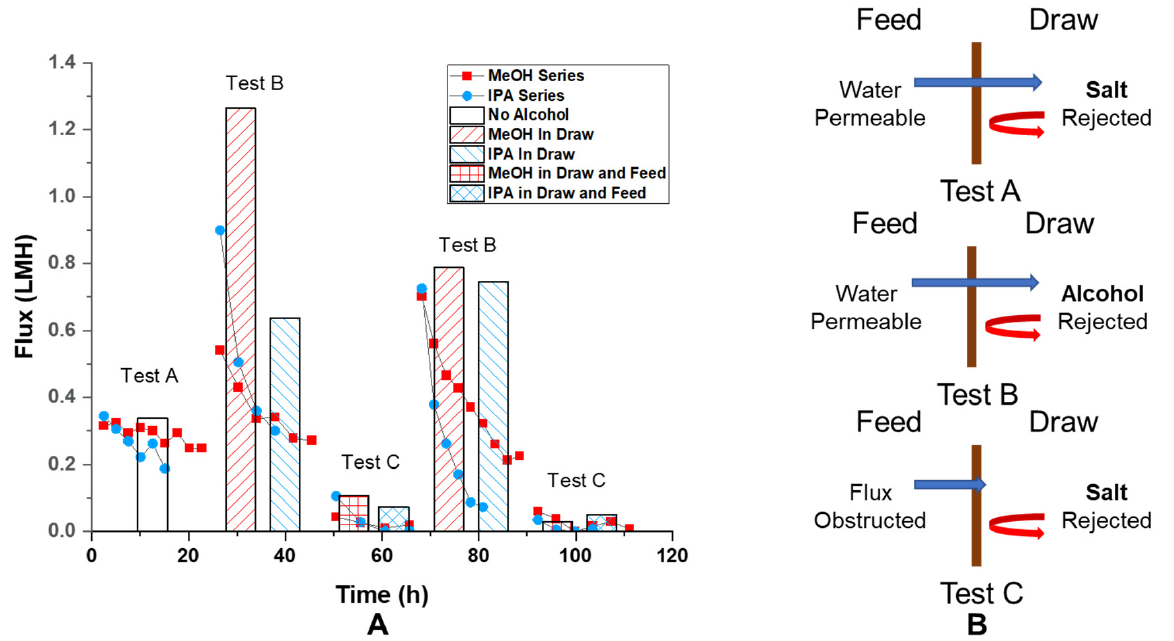
Figure 3. ( A ) Observed osmotic flux vs. time trend on the same GO membrane under different test conditions (scatter plot) and average extrapolated initial flux of different GO membranes under various test conditions (columns); ( B ) schemes of cross-membrane flux under different test conditions. Test A: feed: 10 mM (mmol/L) NaCl in water, draw: 1 M (mol/L) NaCl in water, n = 7; test B: feed: 10 mM NaCl in water, draw: 10 mM NaCl in water–alcohol mixture, n = 1 for MeOH and 4 for IPA at the first test, n = 2 for MeOH and 3 for IPA at the repeat test; test C: feed: 10 mM NaCl in water–alcohol mixture, draw: 1 M NaCl in water–alcohol mixture n = 2 for MeOH and 3 for IPA at the first test, n = 2 for MeOH and 2 for IPA at the repeat test. Test B and C were repeated under the same condition. The number “n” is the number of tests used to calculate the average flux under the same condition specified by the corresponding legend (columns). The water–alcohol mixture is made by mixing 1:1 v/v water and alcohol (MeOH or